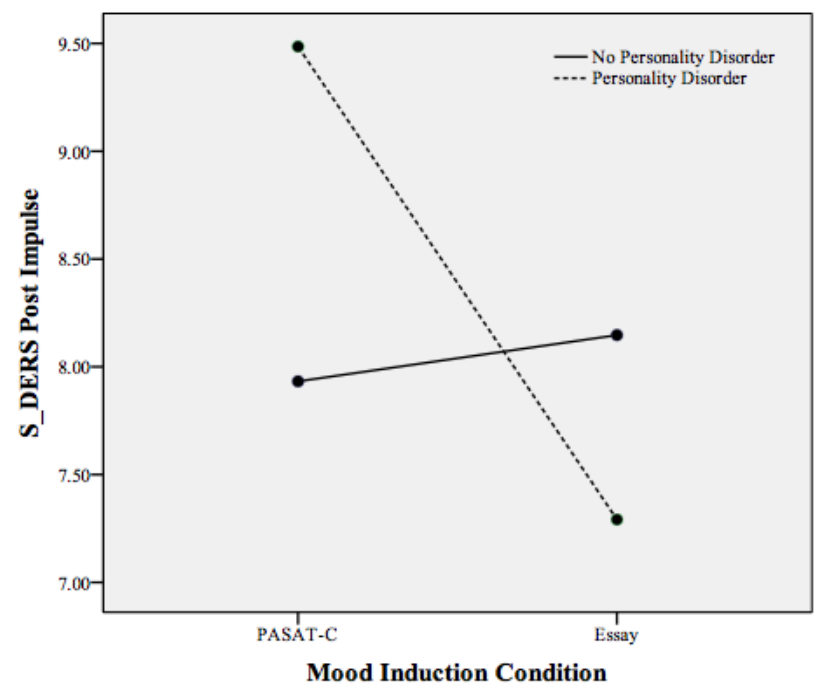
Figure 2. Plot of the statistically significant interaction between mood induction condition and personality disorder on the S-DERS subscale of state impulse control difficulties following both mood inductions. Higher scores indicate more impulse control difficulties.